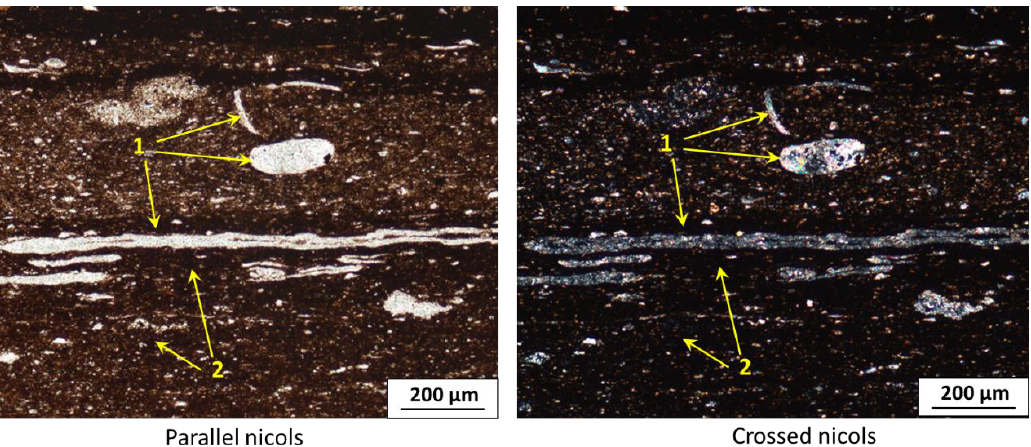
Figure 2. Microphotographs of Ch-46t sample, demonstrating organic matter and mineral heterogeneity; 1—mineral components (light color), 2—organic matter (dark brown). Table 1. Mineral composition of sample Ch-46t according to X-ray powder diffractometry. Calcite, % Quartz,